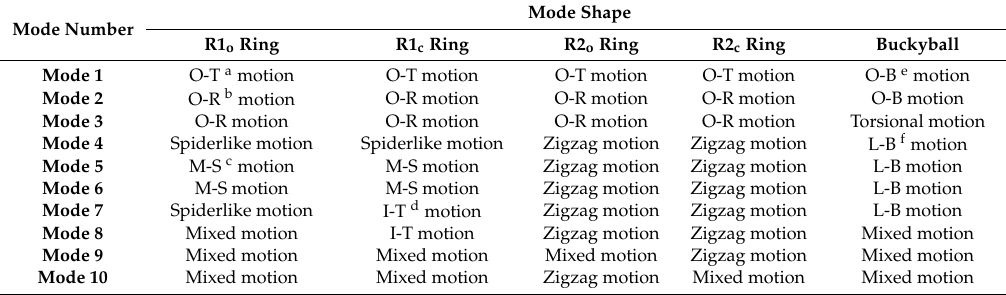
Table 1. Vibrational mode shapes of finite-size DNA 2D ring and 3D buckyball